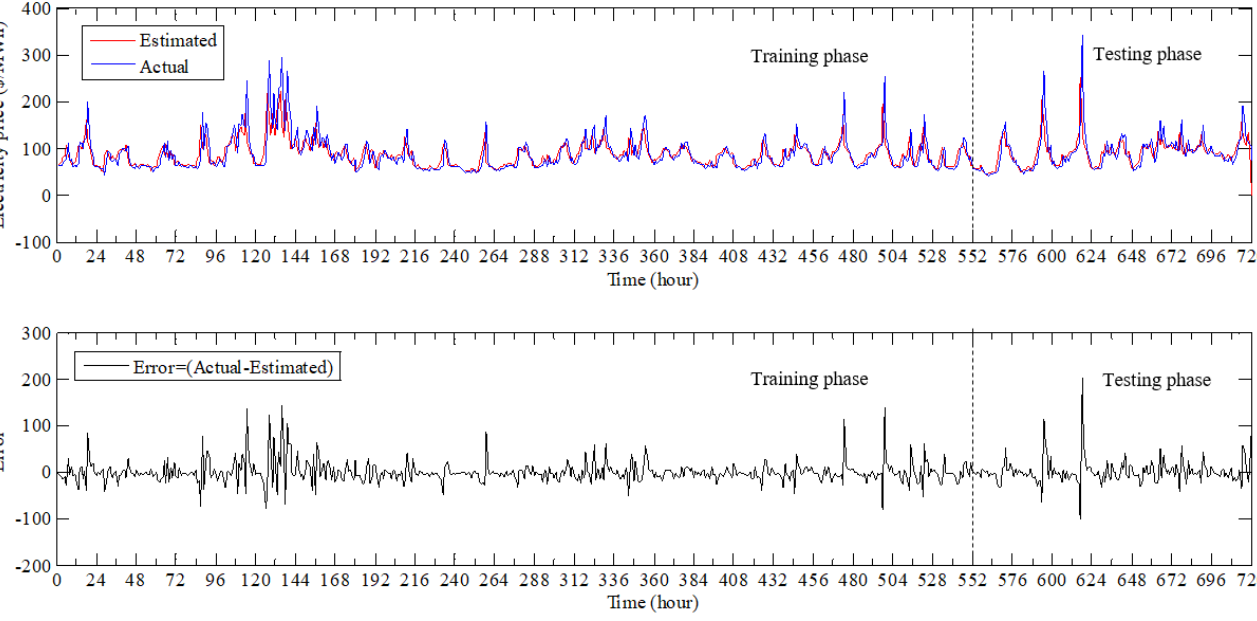
Figure 8. The evaluation of the performance throughout training at the stage of designing and testing phase of ANFIS-BSA and its corresponding error of EPF in November 2018 for QLD.